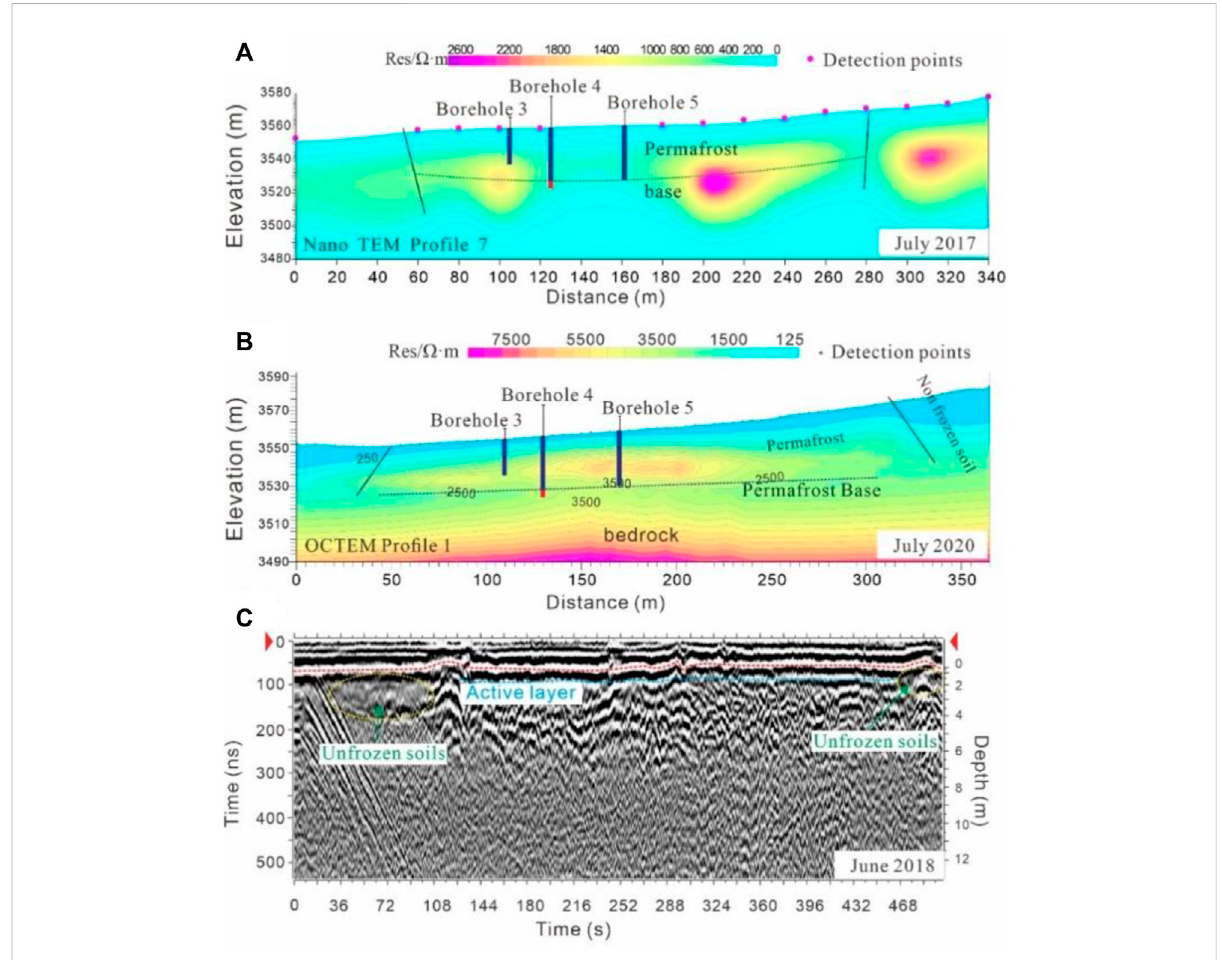
FIGURE 8 Comparison of the nano-TEM, OCTEM, and GPR methods in identifying permafrost in the shallow bedrock area of Mahan Mountain. (A) Nano- TEM pro fi le with a 20-m point spacing. (B) OCTEM pro fi le with a 5-m point spacing. (C) 50-MHz GPR detection pro fi